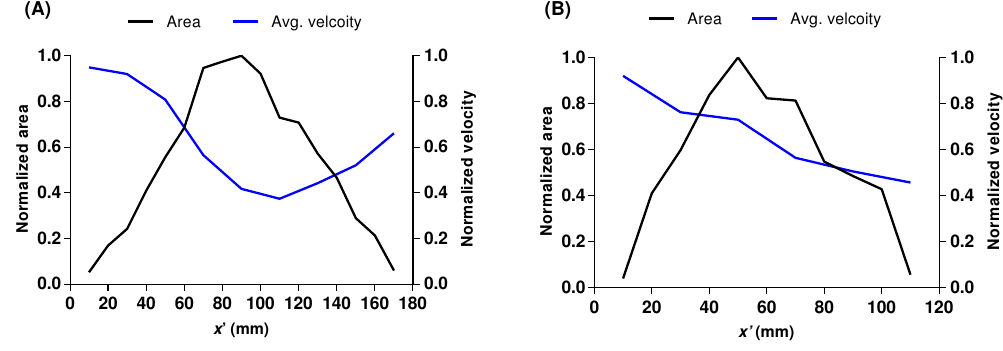
Figure 9. Mean velocity profile and internal cross-sectional area ( y - z plane) along the length of ( A ) the densely branched P. meandrina colony and ( B ) the loosely branched P. eydouxi colony. Here, the area and velocity are normalized by the maximum cross-sectional area and oncoming velocity magnitude,